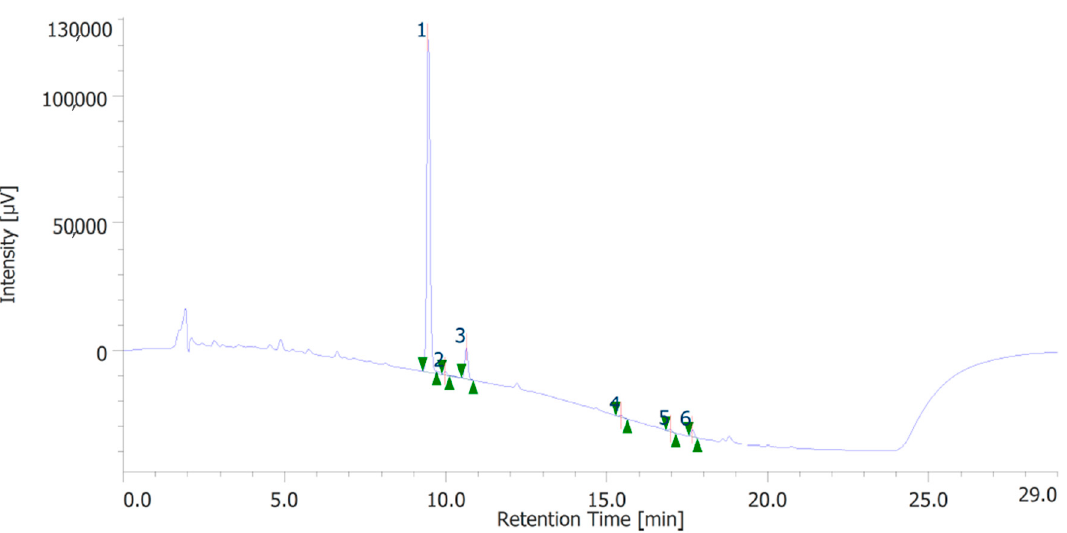
Figure 4. Terphenolic compounds identified in the hydroalcoholic extract of hemp leaves. Among the compounds quantitatively determined, cannabidiolic acid (peak #1: 21.71 μ g/mL) and cannabidiol (peak #3: 3.52 μ g/mL) were the most prominent.